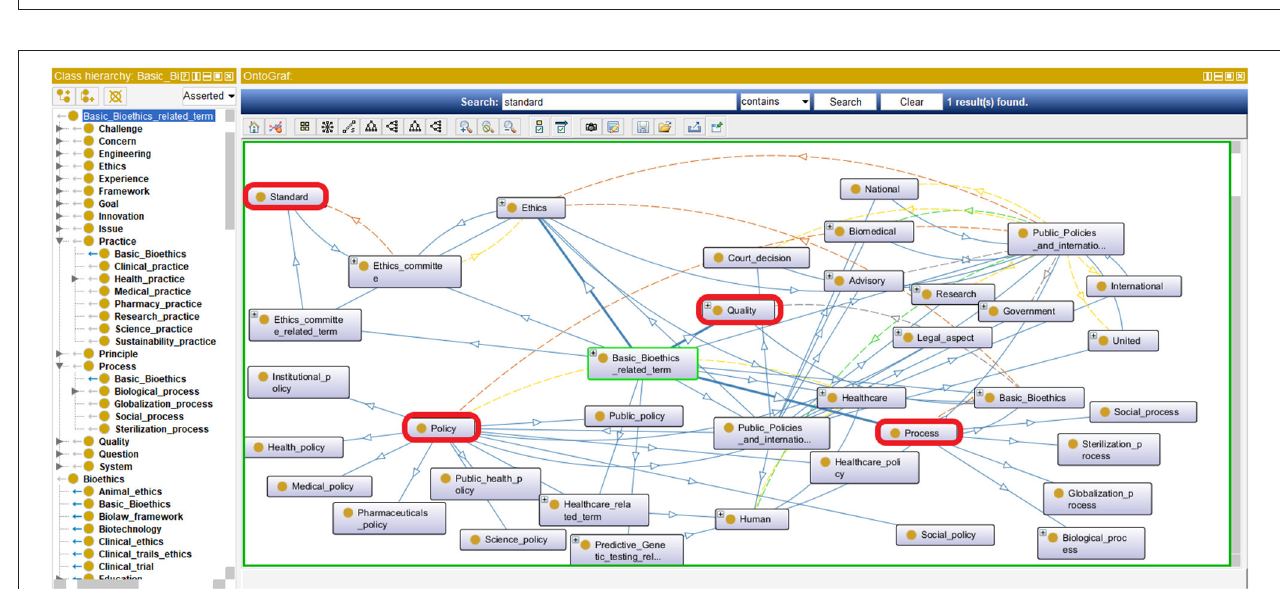
FIGURE 9 | Part of the final bioethics ontology’s class hierarchy.